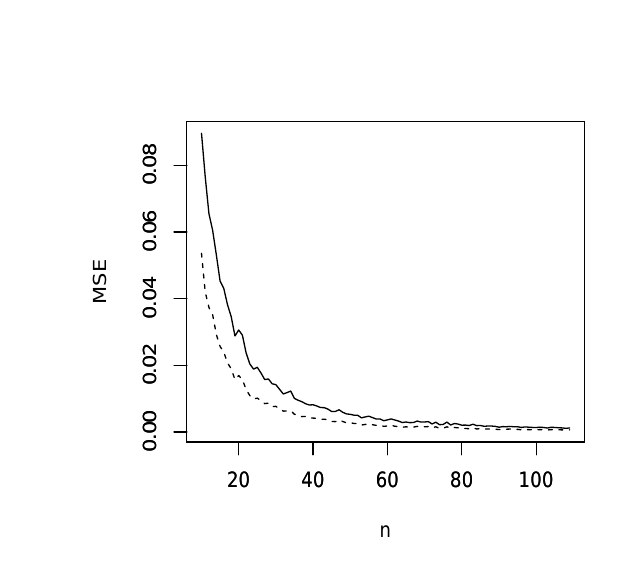
Figure 2 – Mean squared errors of Zinodiny et al. (2017)’s estimator (solid curve) and the estimator in Theorem 8 (broken curve) versus n